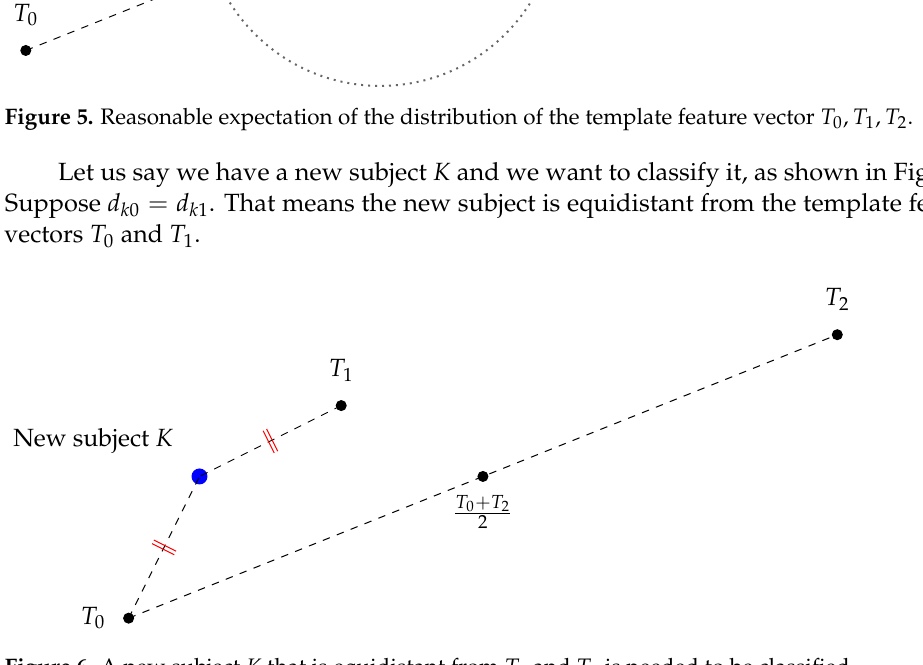
Figure 6. A new subject K that is equidistant from T 0 and T 1 is needed to be